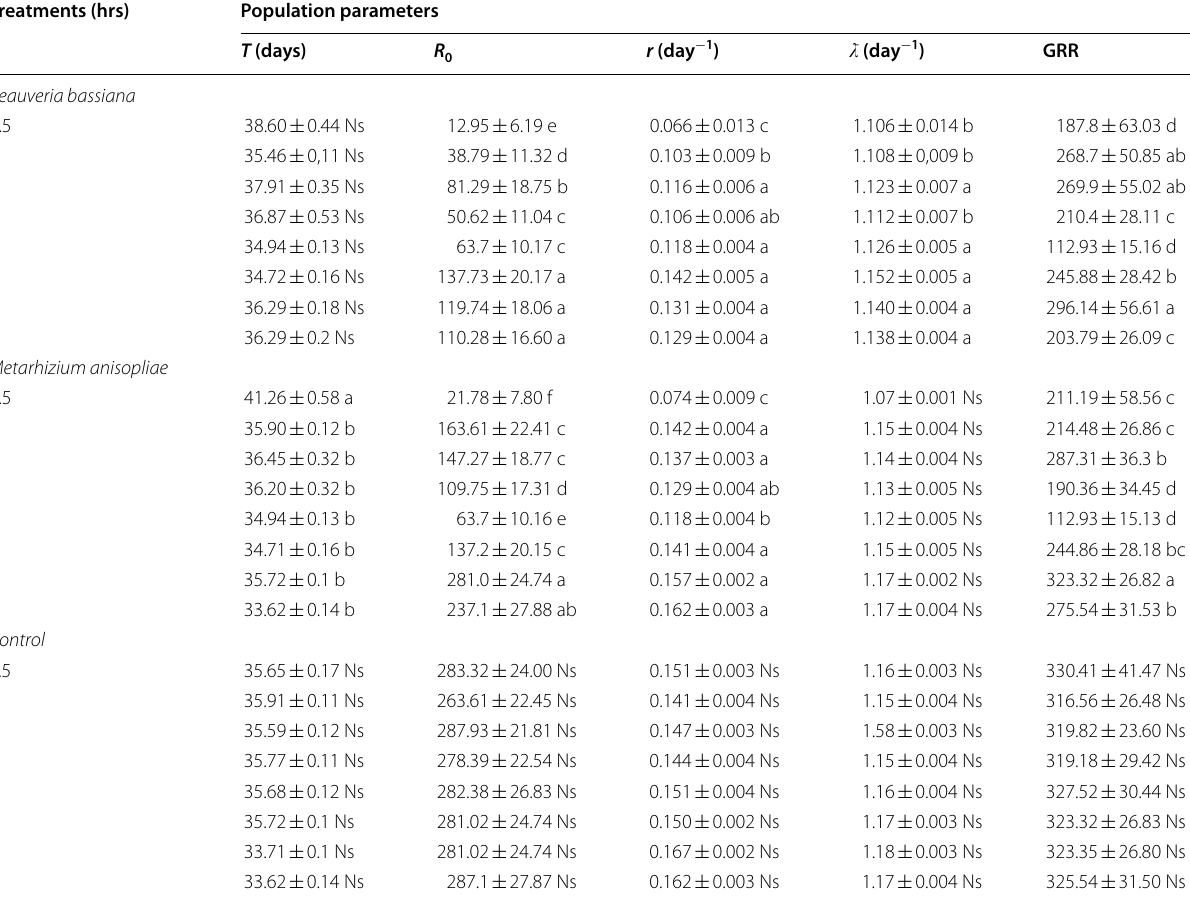
Table 5 Mean life history parameters ( standard error) of the life table of Helicoverpa armigera at different collection times after the ± application of the fungi Beauveria bassiana and Metarhizium anisopliae to the soybean crop in the first season (2019) over a single generation at 25 1 °C and 70% 10% RH ± ±